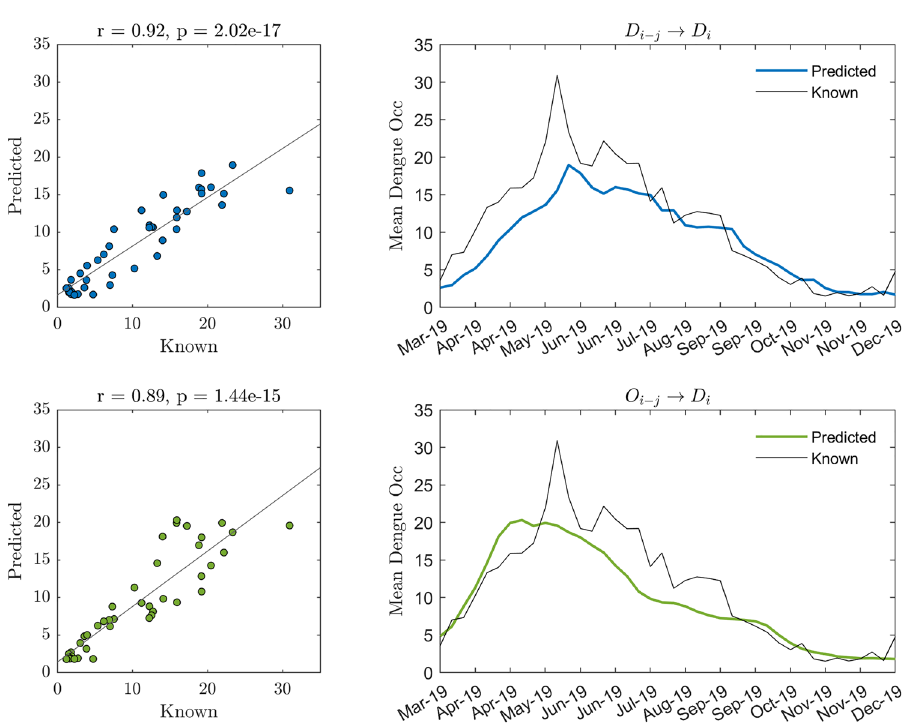
Figure 3. Predictions of LSTM models were trained and tested 30 times. Left panels depict the scatter plots for Observed vs. Predicted values. The right panels show the time series of the mean of the predicted values for the 30 repetitions and the observed values for a test set of